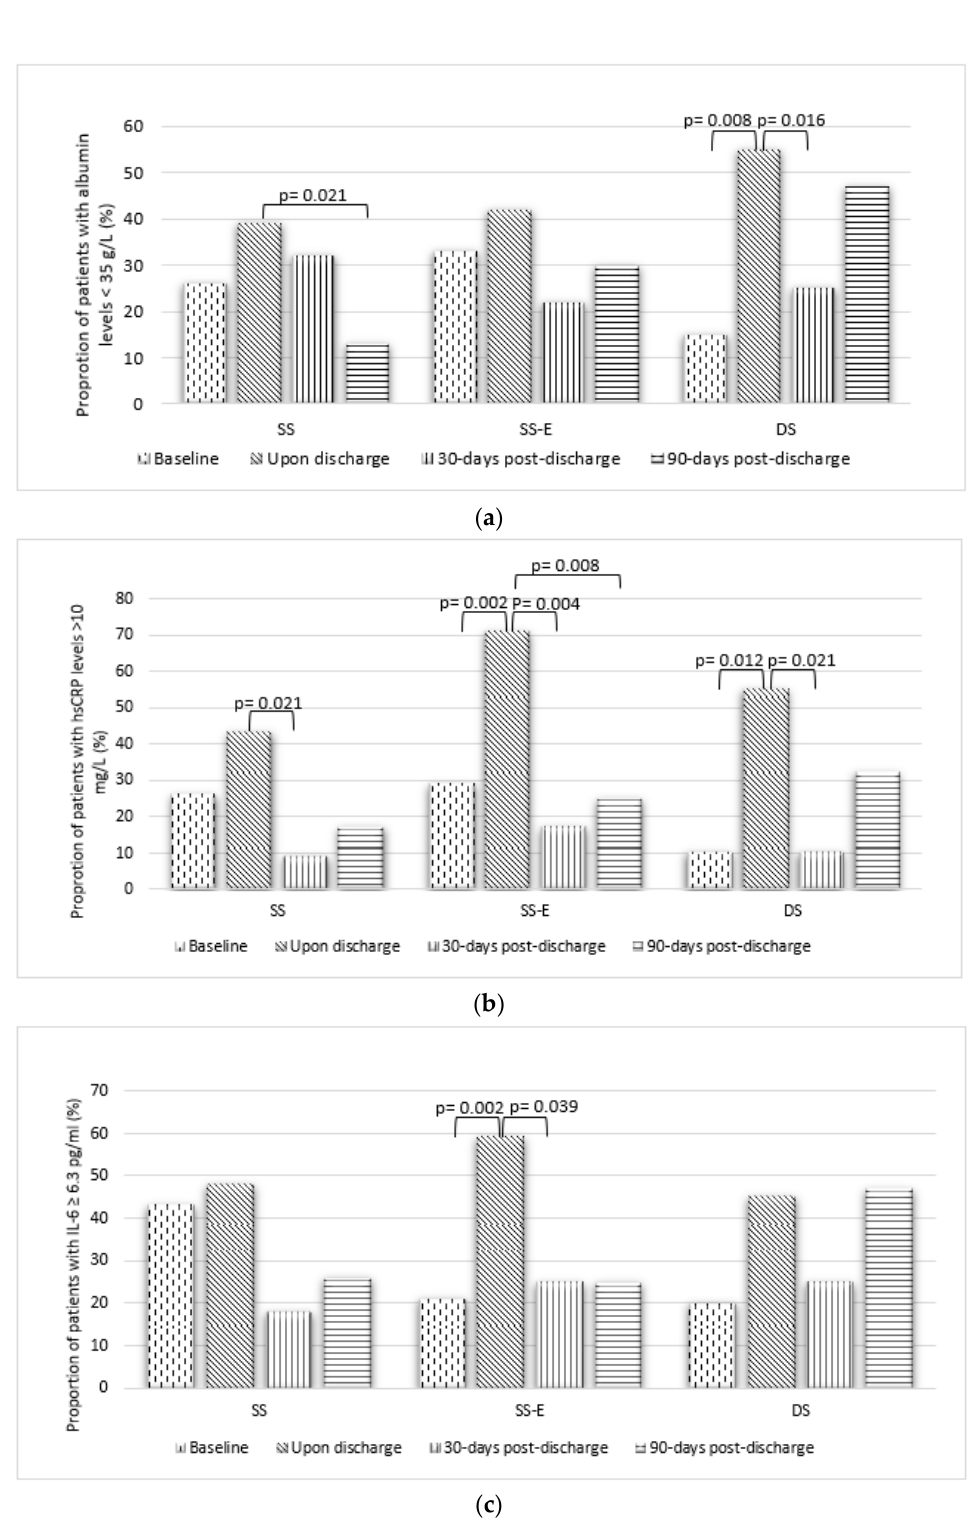
Figure 2. Changes in the proportion of patients with ( a ) albumin < 35 g/L, ( b ) hsCRP > 10 mg/L and ( c ) IL-6 ≥ 6.3 pg/mL. p value indicated significance within groups between timepoints determined by McNemar